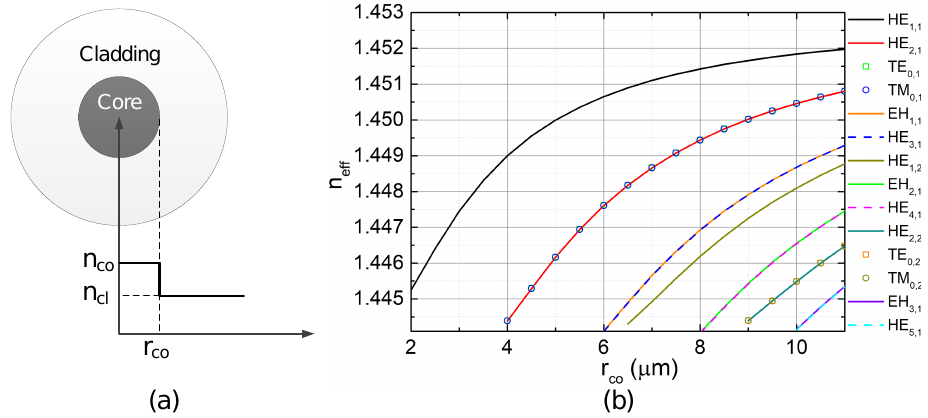
Figure 2. ( a ) The refractive index profile of SI-CCF. ( b ) The variation of n eff versus r co when ( n co − n ) / n co = 0.6% at the wavelength of 1550 nm. cl